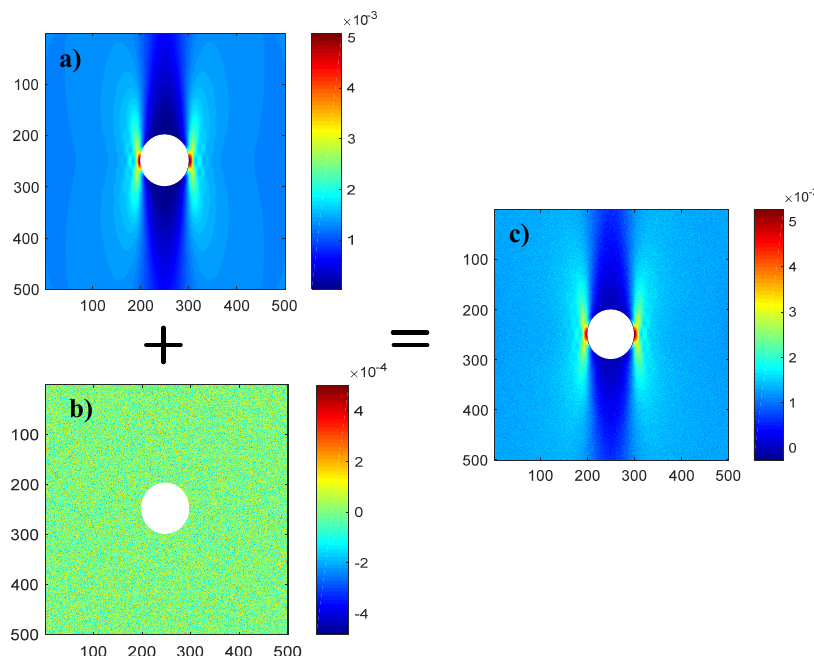
Figure 4. Process of adding random error field on strain field ( ε y ) derived by FE: ( a ) strain field derived from FE; ( b ) a typical sample of random strain field sampled from Gaussian distribution N(0, 1 × 10 − 4 ); ( c ) superposition of Figure ( a ) and Figure ( b ).